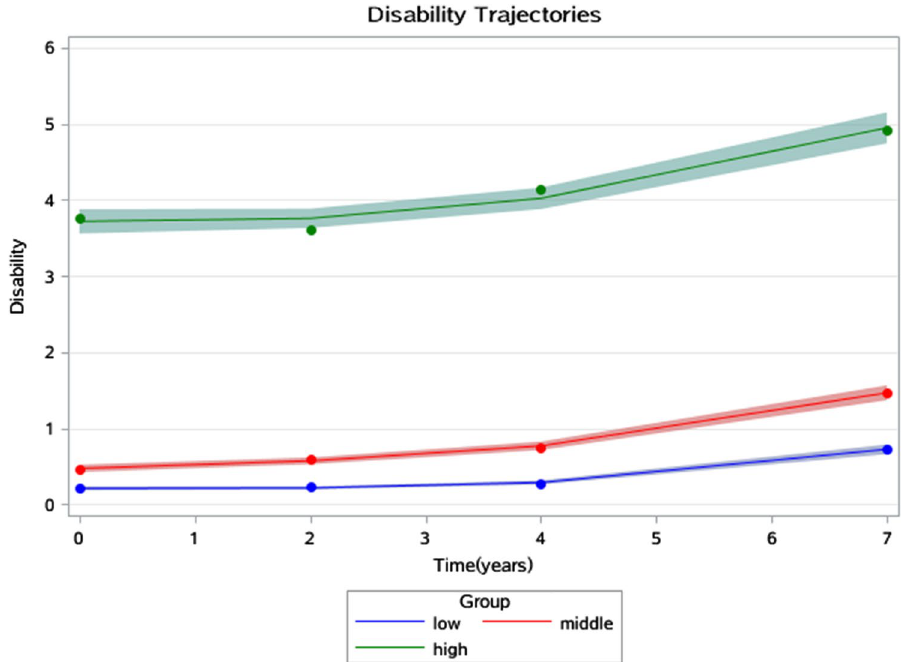
Figure 1. Disability trajectories among a sample of older individuals that survived a 7-year period in China.